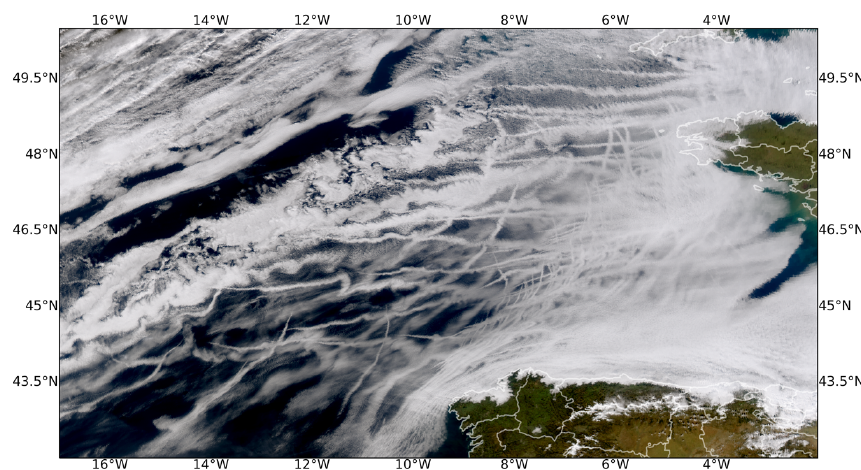
Figure 2. Ship tracks across the Bay of Biscay are shown in true color imagery from MODIS on the Aqua satellite on 27 January 2003 at